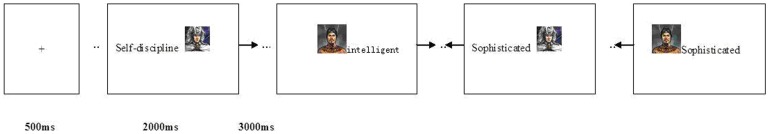
Positive approach - negative avoidance (consistent pattern, visual pictures).The Group 3 condition tested a consistent pattern based on visual pictures. A picture of the reference object was displayed on the screen, and a corresponding personality adjective appeared on either the left or the right side of the picture.